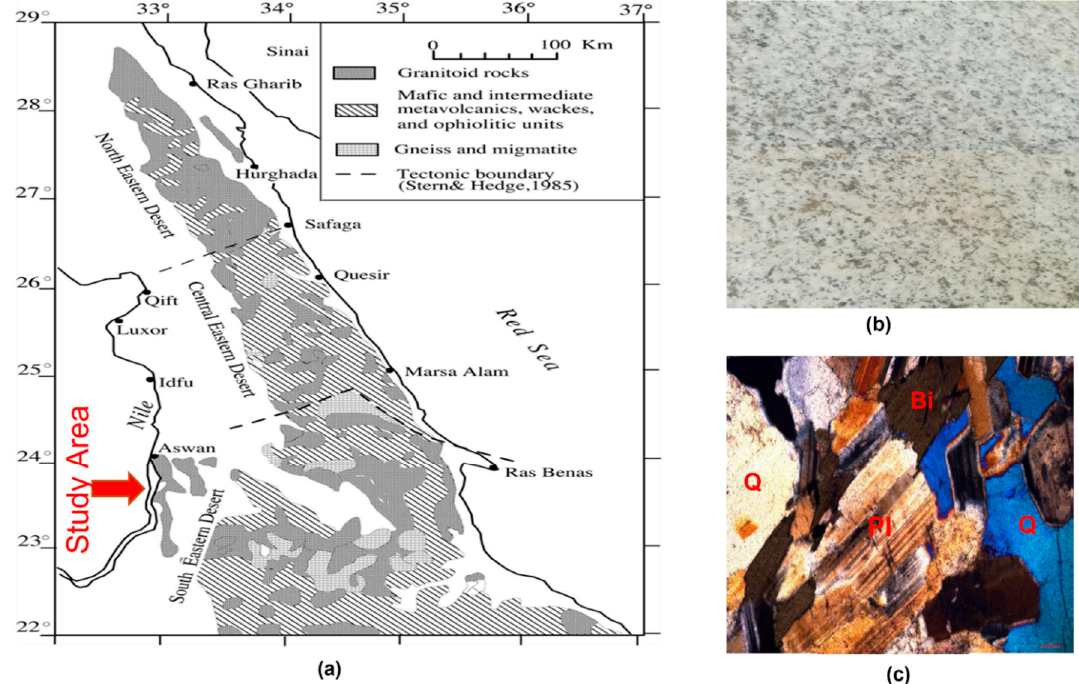
Figure 1. ( a ) Geological map of the studied area, ( b ) granodiorite appearance, and ( c ) a thin section micrograph of granodiorite.